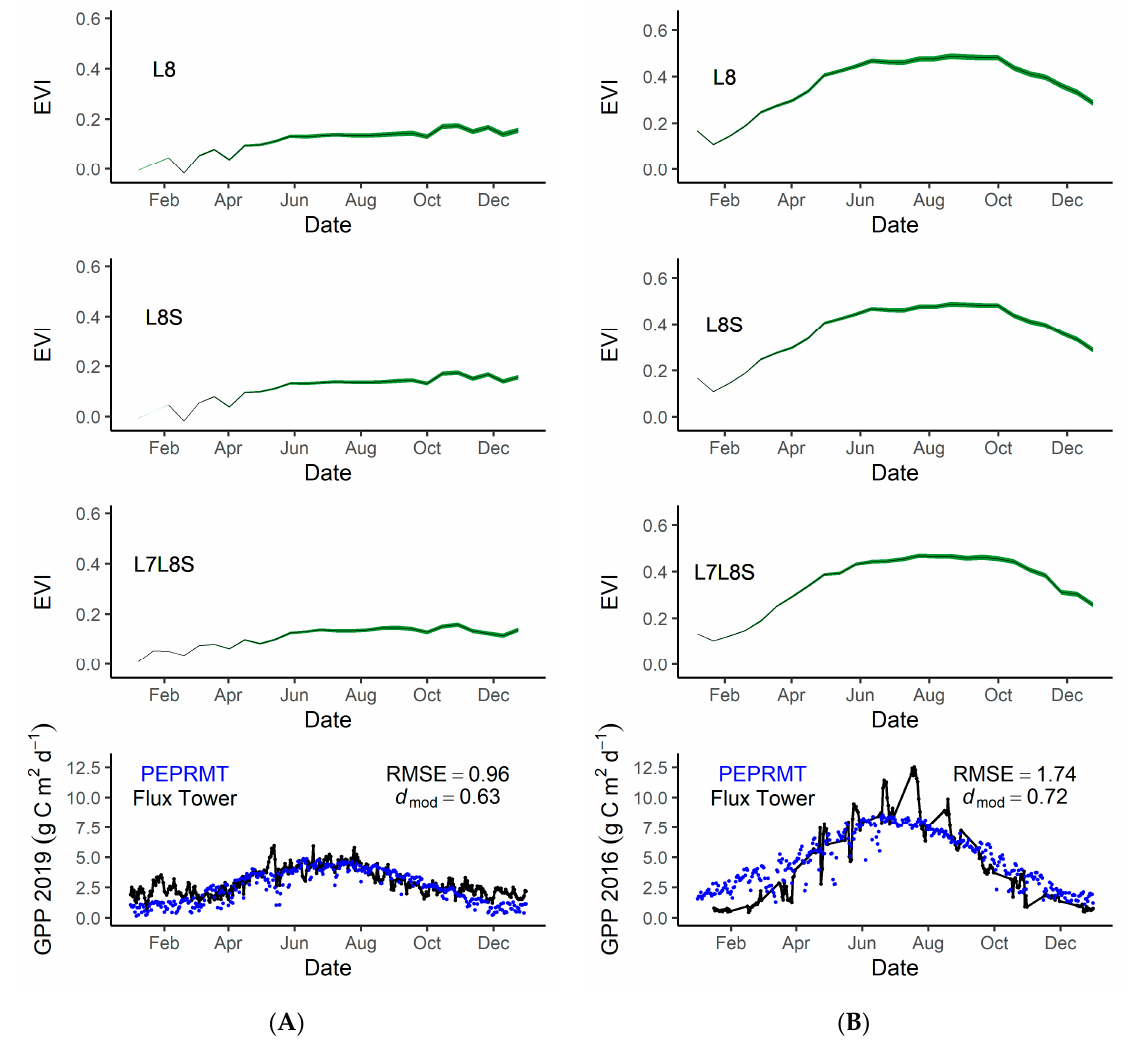
Figure 6. Top graphs are the 2019 predicted EVI values for Eden Landing ( A ) and Rush Ranch ( B ) using three different EVI history datasets. L8 indicates modeled EVI using Landsat 8 for EVI history, L8S indicates modeled EVI using Landsat 8 and Sentinel-2 for EVI history. L7L8S indicates modeled EVI using Landsat 7, Landsat 8, and Sentinel-2 for EVI history. The bottom graphs are eddy covariance measured gross primary production (GPP) at Eden Landing in 2019 ( A ) and Rush Ranch in 2016 ( B ). The green lines represent the predicted EVI values, the black dots and lines indicate the eddy covariance measured GPP, and the blue dots represent the PEPRMT modeled GPP. Eddy covariance data were not available for 2019 within Rush Ranch, therefore we used 2016 data. Root mean square error (RMSE) and modified Willmott’s index of agreement ( d mod ) for the observed versus predicted GPP are indicated in the figures.